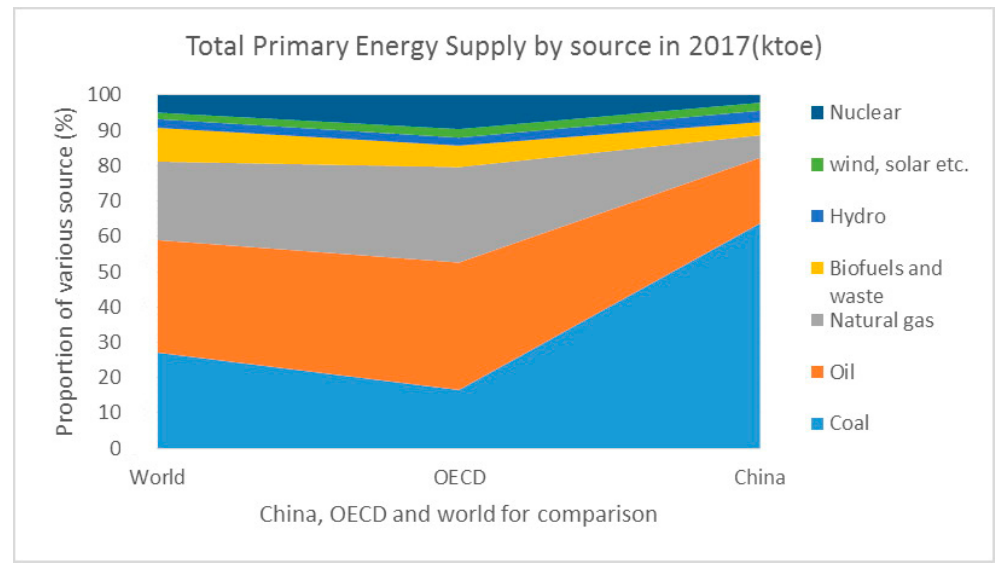
Figure 2. Total Primary Energy Supply by source in 2017. Note: Relevant data are from country profiles of the International Energy Agency (IEA) [32].